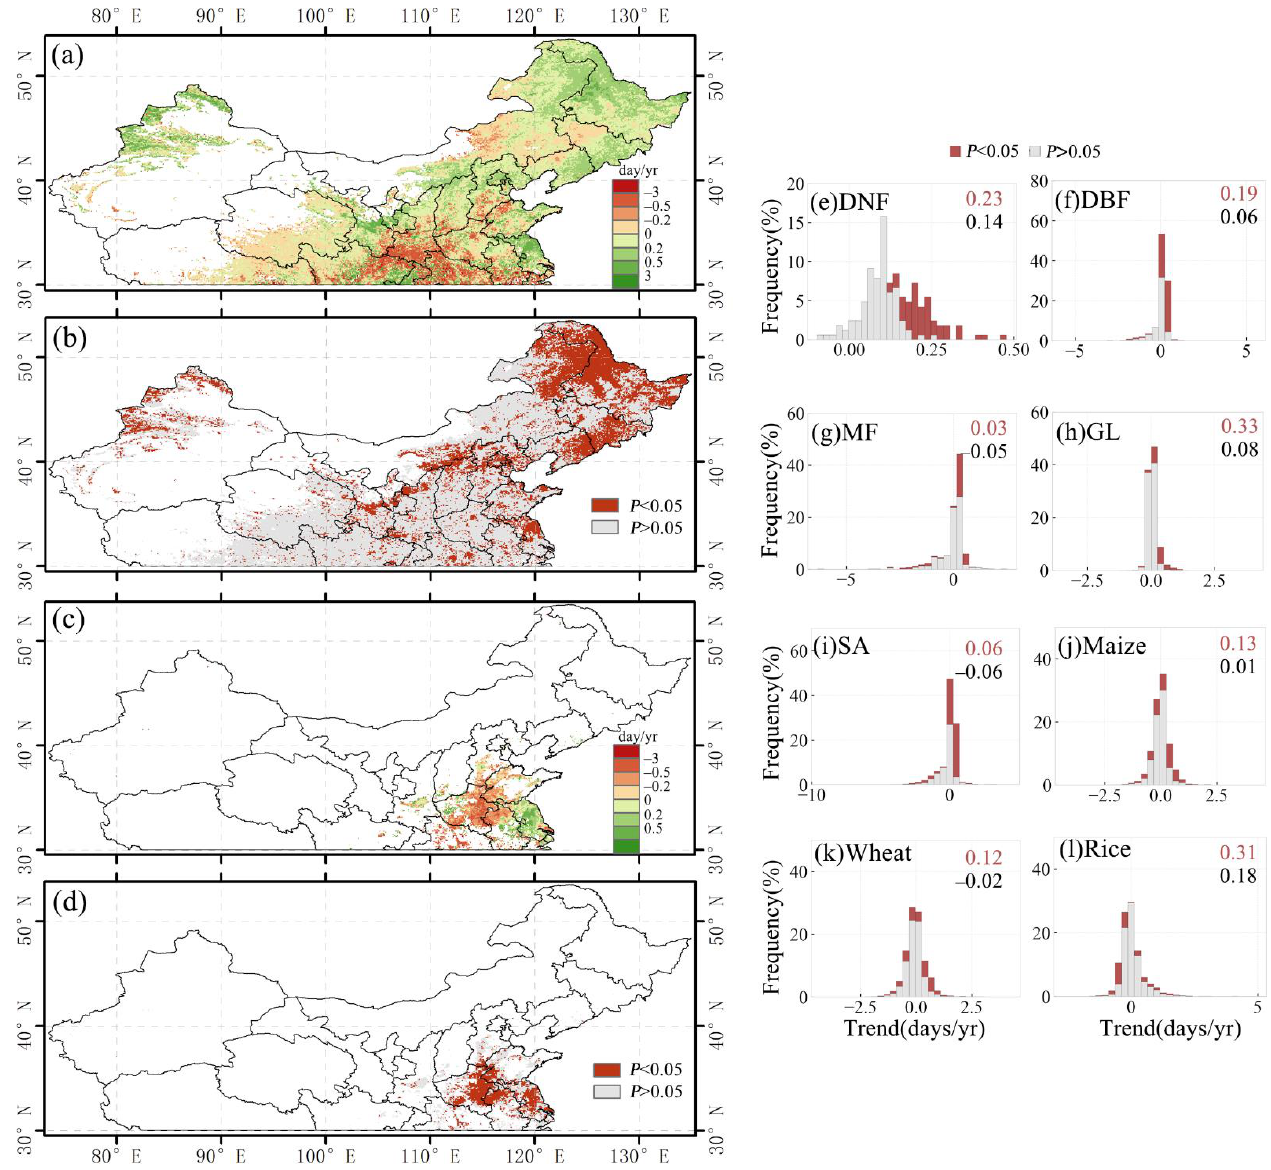
Figure 5. Spatial distribution of the changing trend ( a ) and p -value ( b ) of EOS for the single-season vegetation and the first season of double-season vegetation. Spatial distribution of the changing trend ( c ) and p -value ( d ) of EOS for the second season of double-season vegetation. ( e – l ) Histograms of EOS change trends for different vegetation types. The black text in the upper right corner of the histogram indicates the mean of the trend (days/yr), and the red text is the mean of the part with the p -value < 0.05.